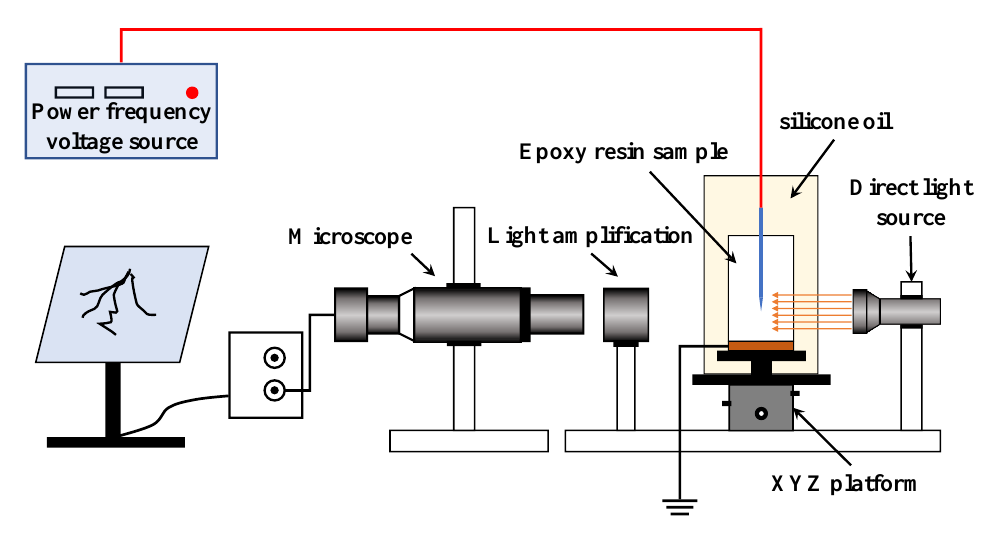
Figure 3. Electrical tree online observation system. Electrical tree test experimental method.